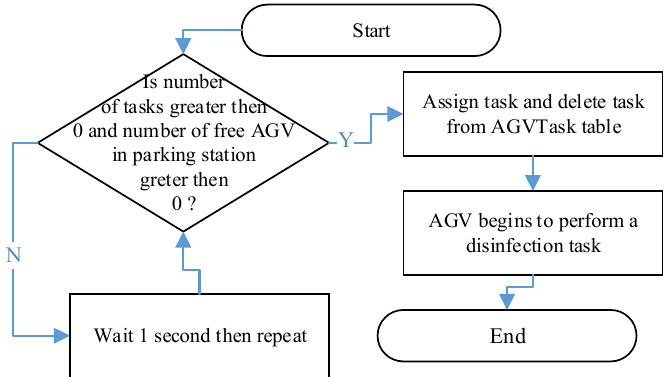
Figure 12. Task assignment logic for AGV, schematically.